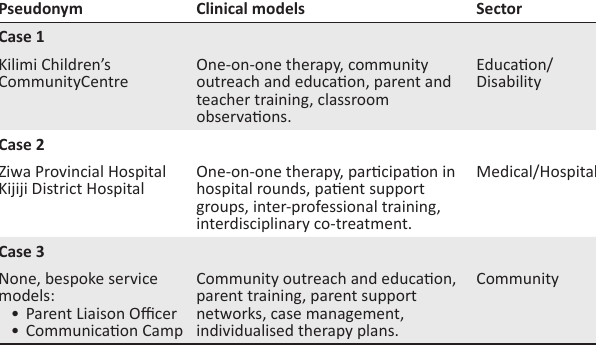
TABLE 1: Characteristics of case studies. Pseudonym Clinical